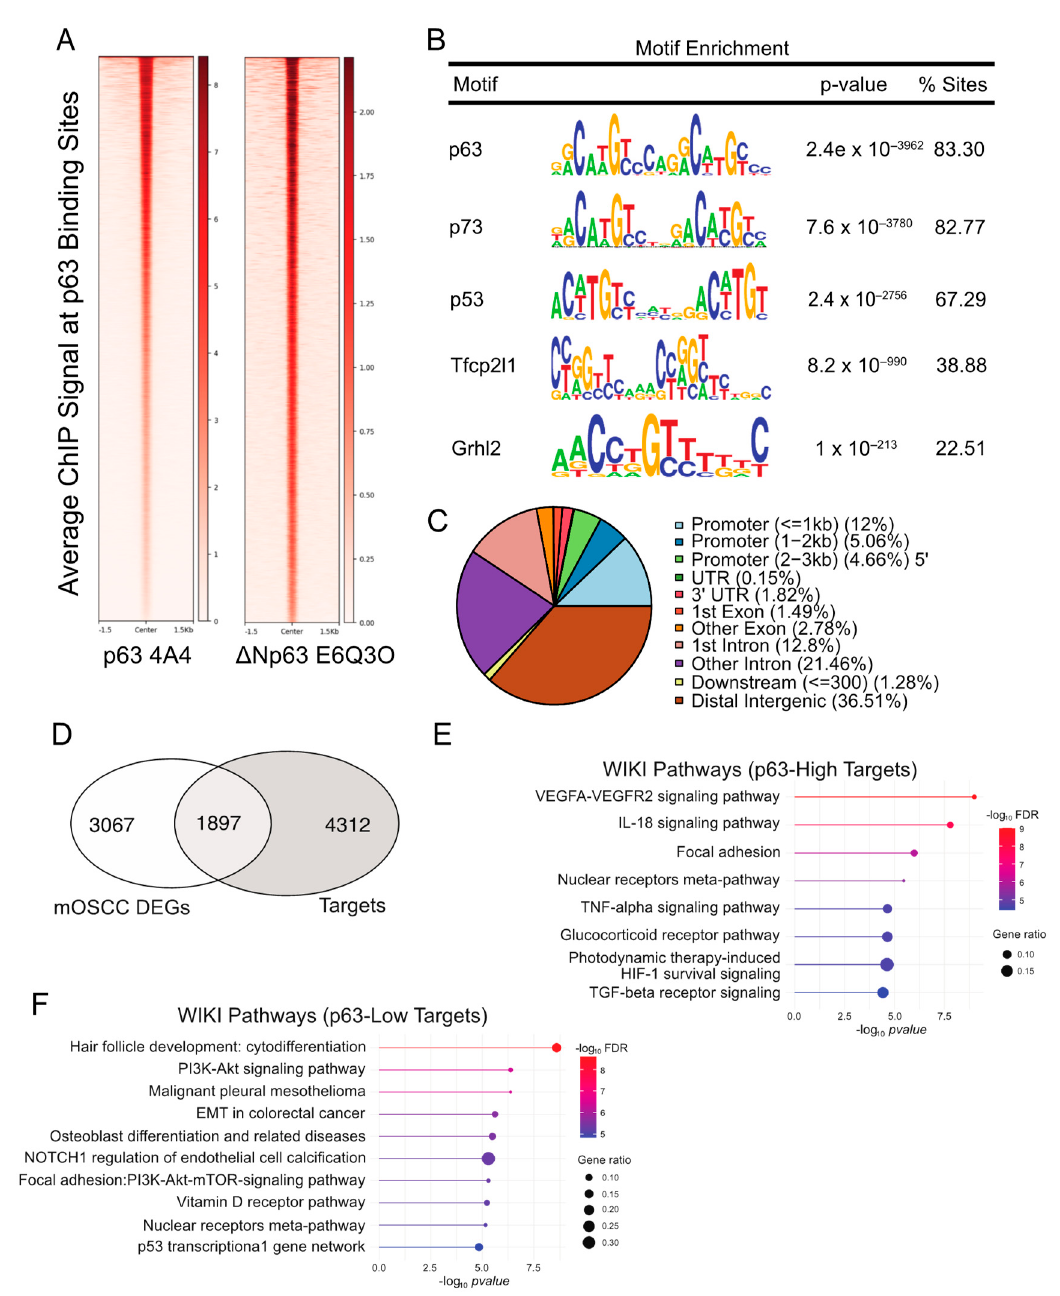
Figure 2. Identification of the p63 global targets in B7E11 cells by ChIP-seq. ( A ) Heat map of the average ChIP-seq signals from p63 binding sites for two p63 antibodies across the genome. ( B ) Top transcription factor motifs derived from CentriMo motif analysis on B7E11 consensus p63 ChIP peaks. ( C ) Distribution pattern of genomic features associated with p63 binding sites across the genome. ( D ) Integration of the identified p63 cistrome with the previously identified cell line-based DEG dataset. Enriched WikiPathways identified for p63 high ( E ) and p63 low ( F ) target genes.